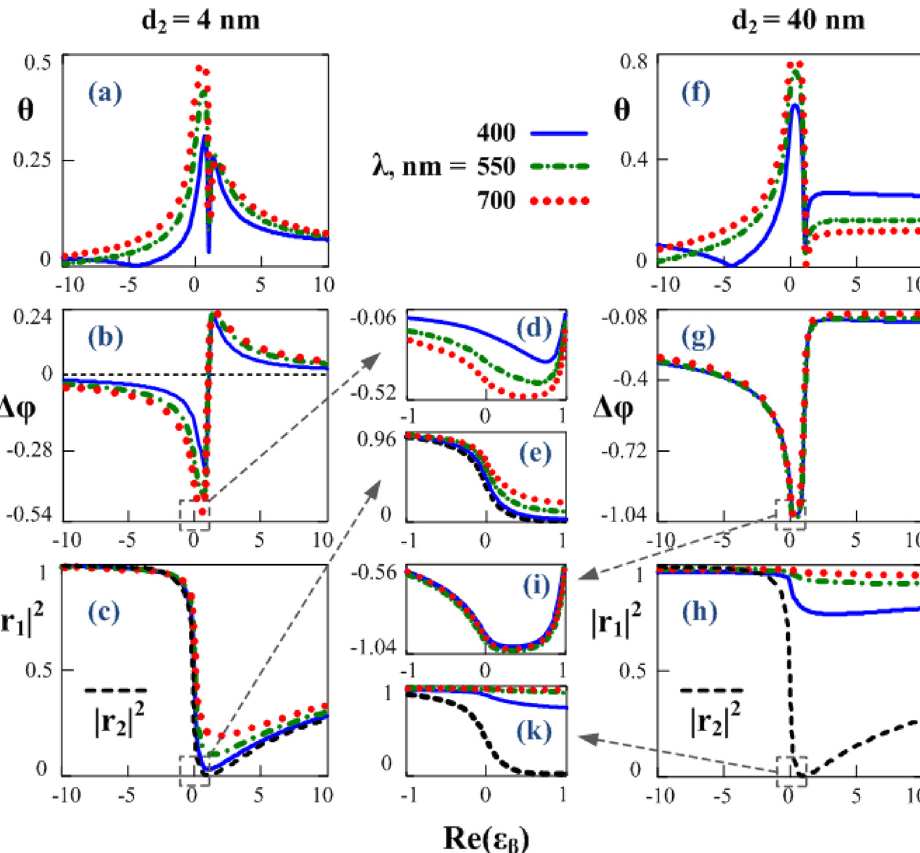
Fig. 4. Dependences of angle u (a, f), PSD of the re fl ected waves (b, d, g, i) and corresponding energy re fl ection coef fi cients (c, e, h, k) on parameter e 0 b for various wavelengths of the incident wave. The values of parameters are: d 2 =4nm (a – e), 40nm (f – k). The values of parametersforallthegraphsare: c =0, d 1,3,4 =0, e 00 b ¼ 0 : 1 , m b =1,themainlayermaterialissilver.Figuresd,e,i,kdetailthecorresponding graphsforthecasesofoptimalparameters(themaximalvaluesof| D ’ |and| r 1,2 | 2 thattakeplacesimultaneouslyatsmallvaluesof j e 0 b j ).The black horizontal dashed line in b corresponds to the condition D ’ =0. Parameter e 0 b is used as the abscissa axis for all the